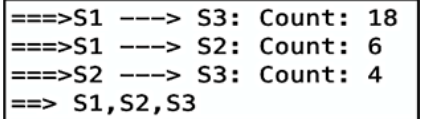
Figure 8. Algorithm 2’s output containing the paths and the count of vectors.